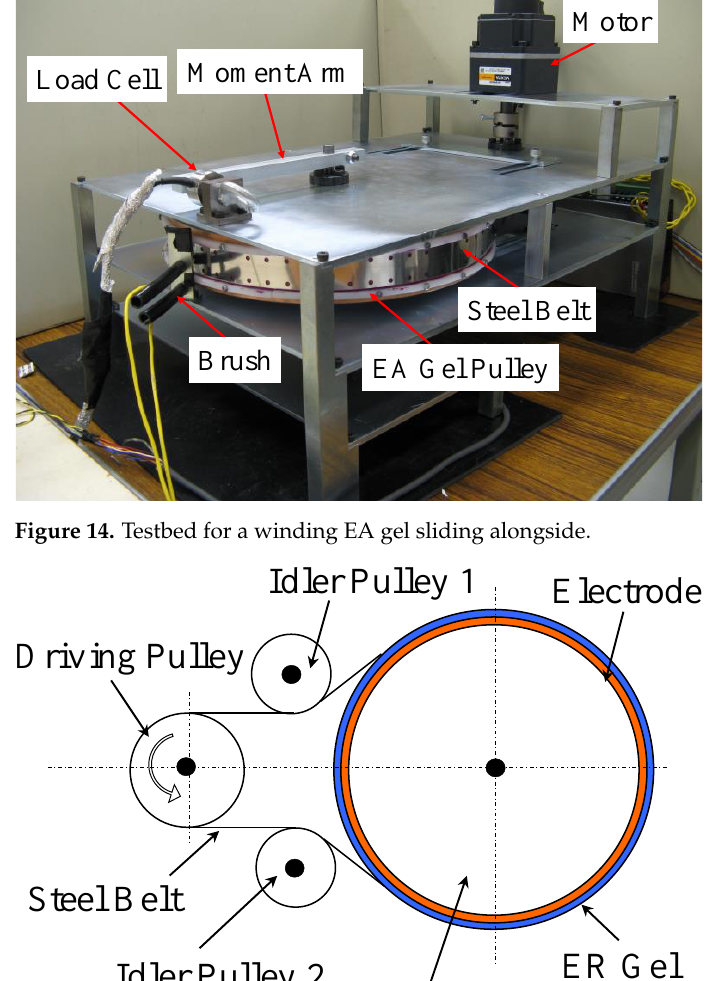
where τ is the shear stress of the EA gel, h is the width, r is the radius of the driven pulley, and ∆ θ is the winding angle at the driven pulley. The relationship between the electric field and the shear stress determined from the step response experiment is shown in Figure 16 [12]. The shear stress was about 5 kPa at 1 kV/mm, which was approximately what was